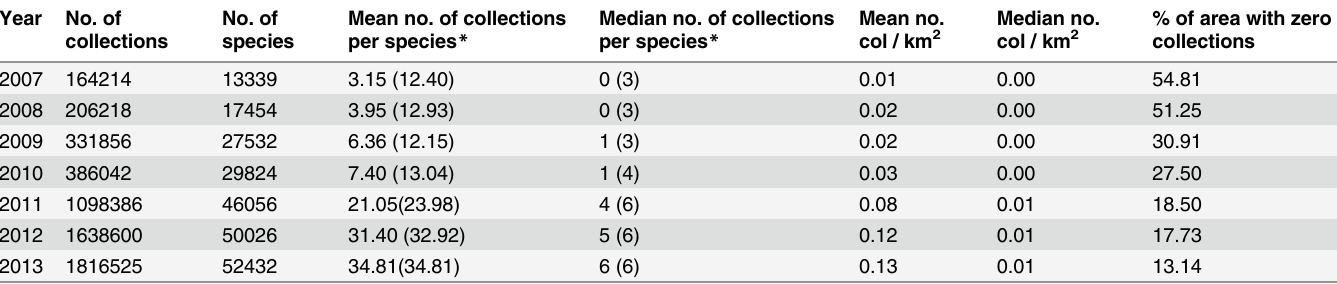
Table 1. The availability of plant collections data through the Global Biodiversity and Information Facility (GBIF). Year No. of